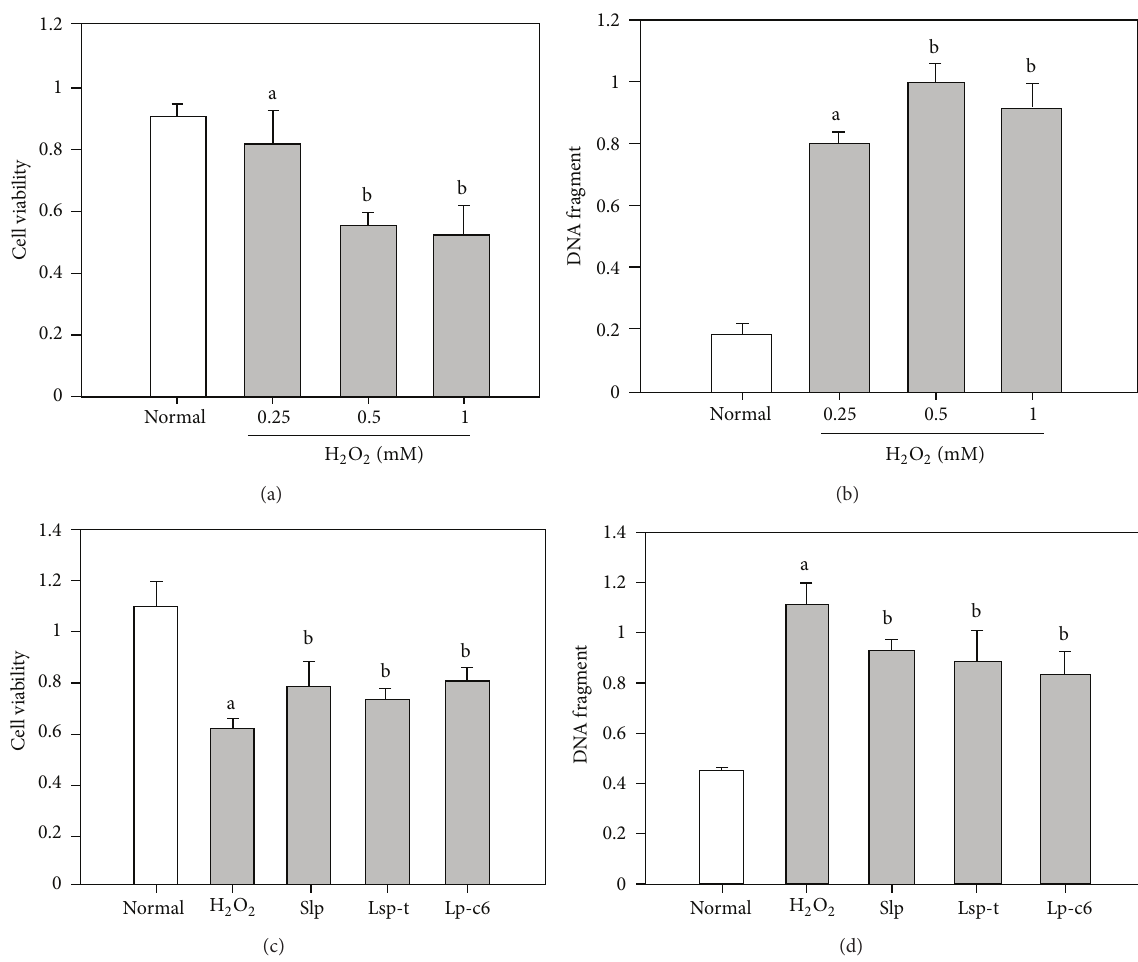
Figure 6: Effects of recombinant Slp and Lsp-t on cell viability and apoptosis in H 2 O 2 -induced HUVEC cells. (a) Cellular viability analysis following treatment of HUVEC cells with different concentrations of H 2 O 2 as determined by MTT assay. (b) DNA fragmentation analysis in HUVEC cells treated with different concentrations of H 2 O 2 as determined by ELISA assay. (c) The effects of Slp and Lsp-t on cellular viability in H 2 O 2 -treated HUVEC cells as determined by MTT assay. (d) The effects of Slp and Lsp-t on DNA fragmentation in H 2 O 2 -treated HUVEC cells as determined by an ELISA assay. Purified silkworm lipoprotein 30Kc6 (Lp-c6) was used as a positive control. Different letters refer to the levels of statistical significance at 𝑃 < 0.05 . Where the letters match, this refers to no statistical difference between the sets of